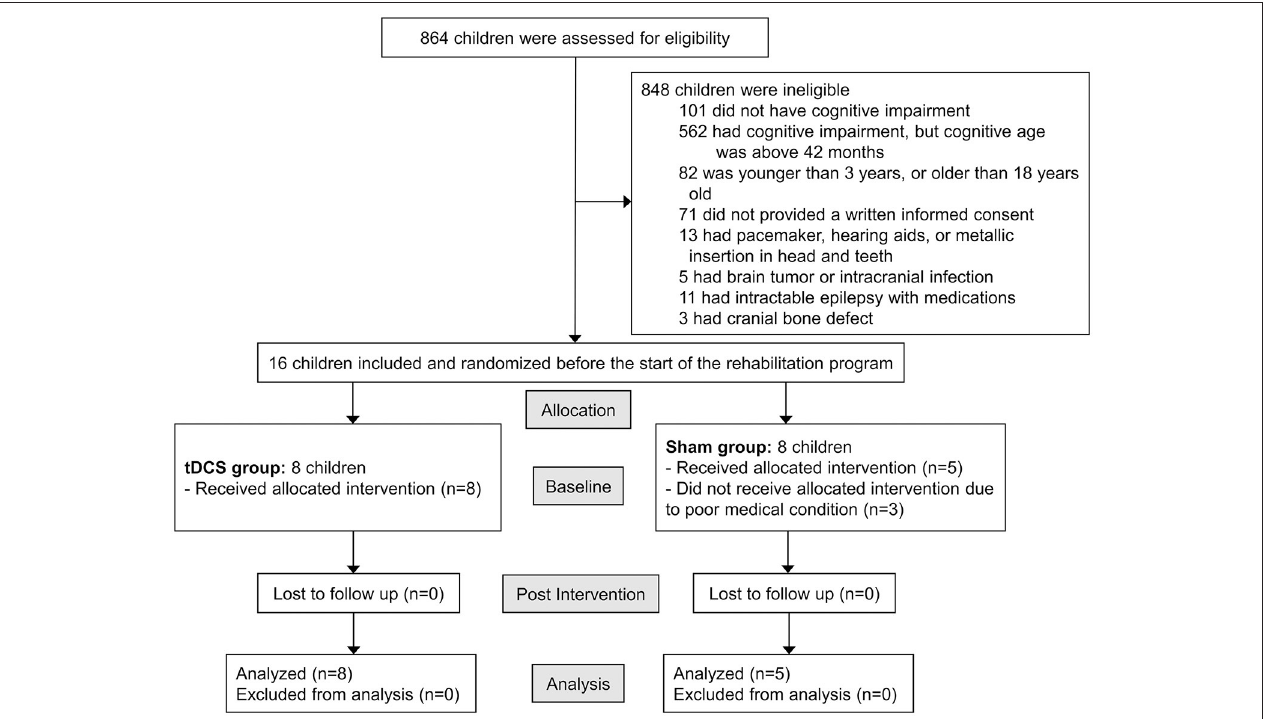
FIGURE 1 | Participant enrollment flow